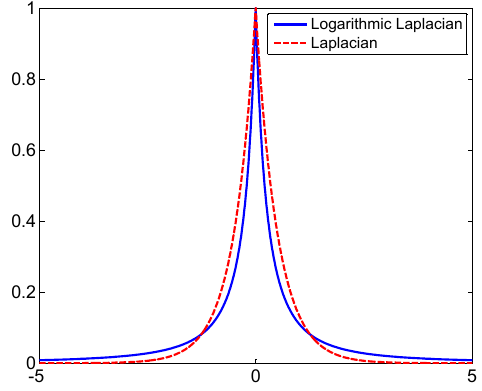
Figure 1. Comparison of the Laplacian and logarithmic Laplacian